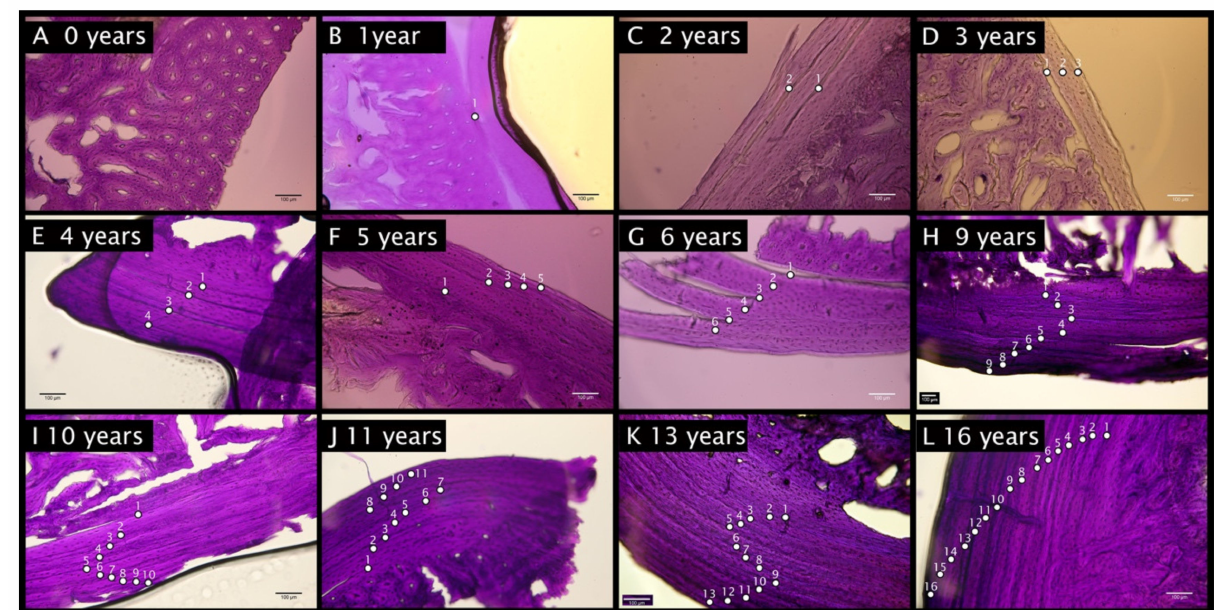
Figure 2. Illustrated examples of the 12 age categories observed in prepared transverse sections of the lower jaws of European hedgehogs from Denmark. Each white dot shows a growth line, and the small numbers next to each point indicate the numbers of growth lines, and their order, counted in each section. The age categories ranged from 0 years (dying before first hibernation), labeled A, to 16 years, labeled